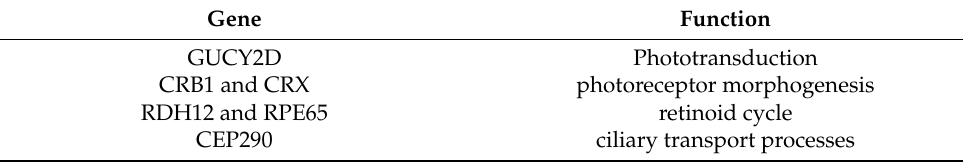
Table 1. Leber congenital amaurosis associated genes and their function. Gene Function GUCY2D Phototransduction CRB1 and CRX photoreceptor morphogenesis RDH12 and RPE65 retinoid cycle CEP290 ciliary transport